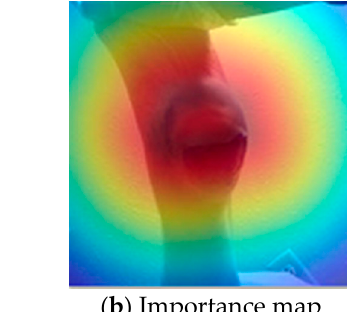
jury: 4.8%, surgical: 7.3% (Lymphovascular).